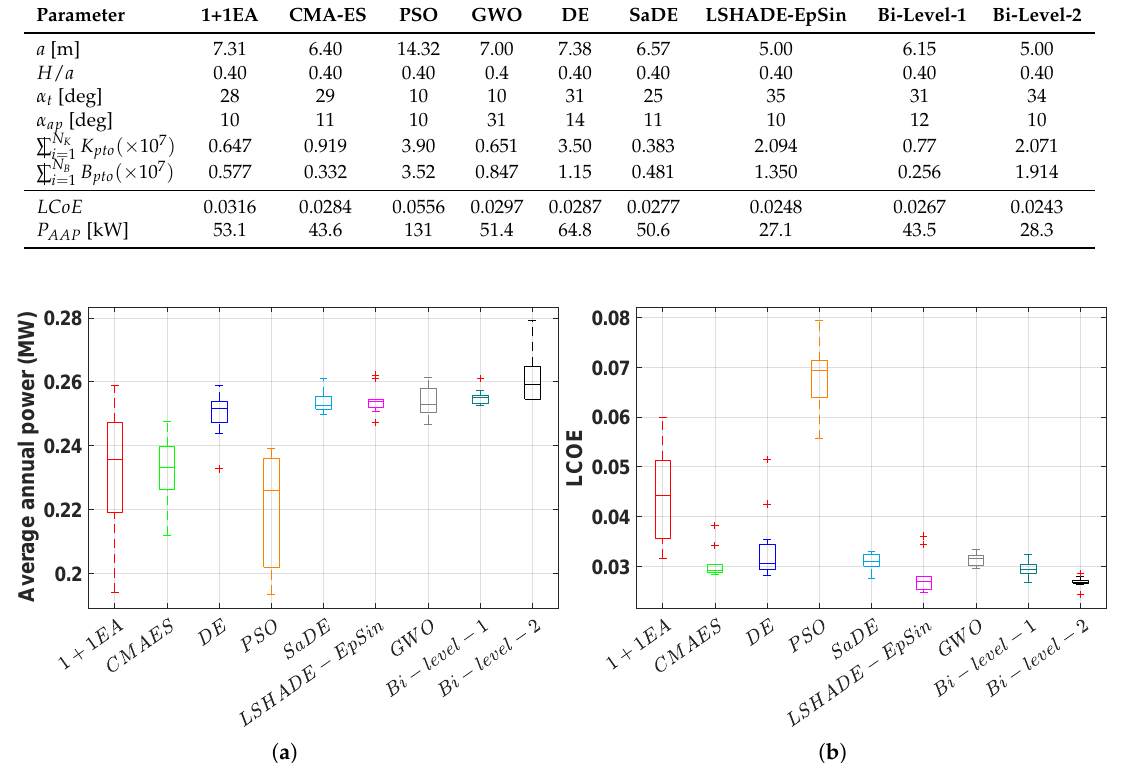
Figure 9. Each method runs 10 times. ( a ) Average annual produced power, ( b ) Levelised cost of energy (LCoE).